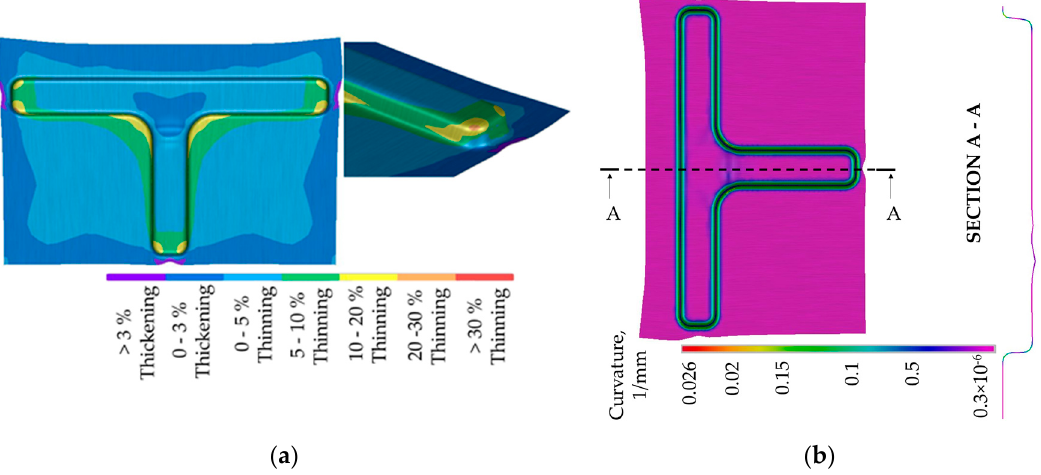
Figure 9. Results of ( a ) thinning and ( b ) curvature on the component.